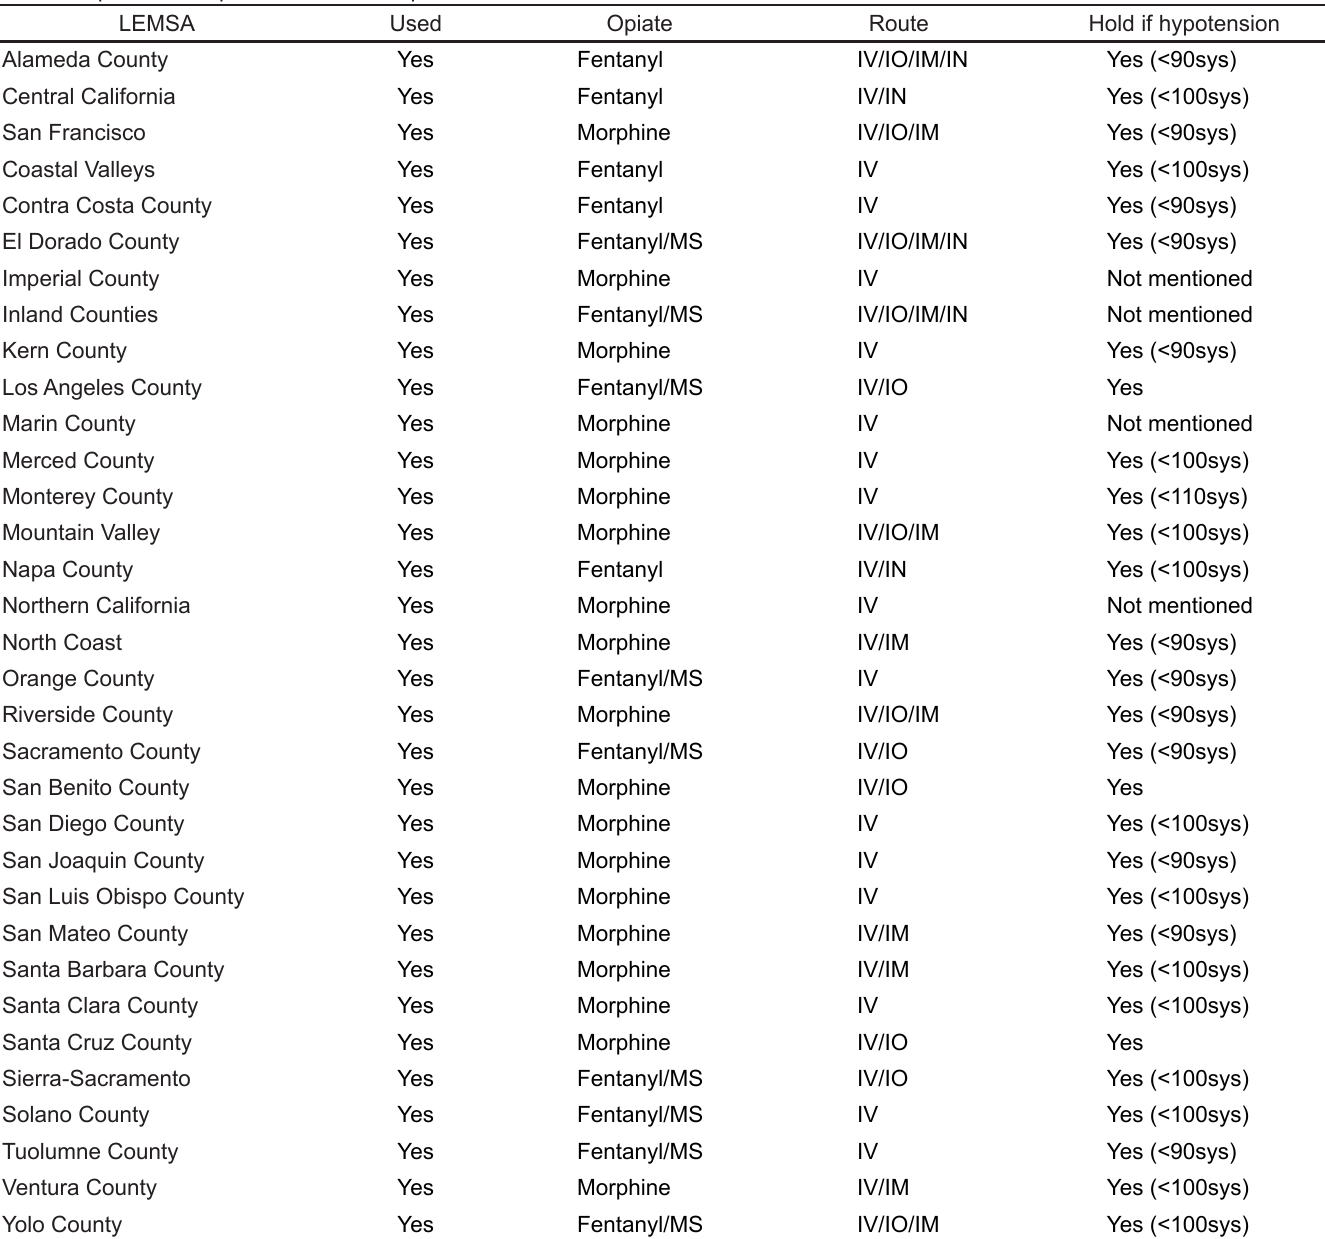
Table 4. Opiate use in patients with chest